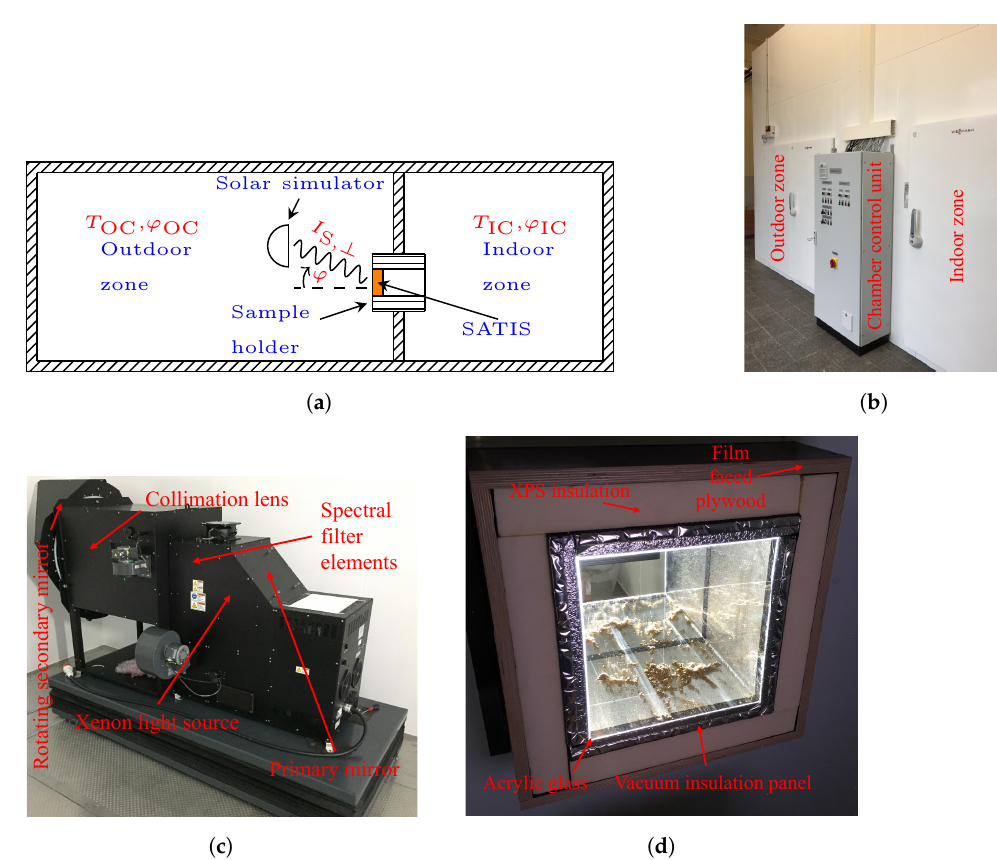
Figure 2. Illustration of the differential climatic chamber, consisting of an indoor and an outdoor zone ( a , b ), the solar simulator ( c ) and the sample holder ( d ). ( a ) Schematic representation of the experimen- tal setup for investigating SATIS. ( b ) Front view from the outside of the differential climatic chamber. ( c ) Solar simulator in the outdoor zone. ( d ) Sample holder consisting of a multi-layer